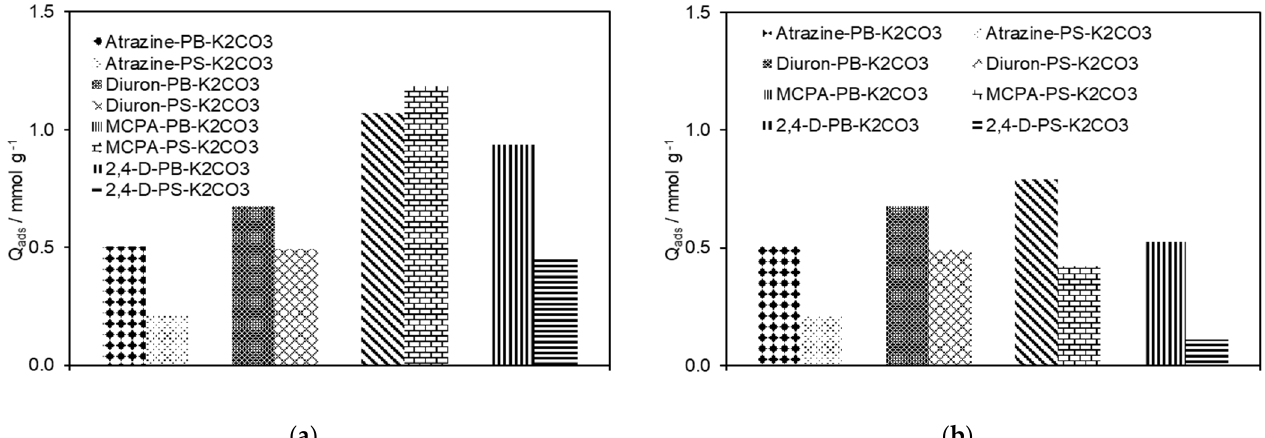
Figure 5. Adsorption kinetics of 2,4-D and MCPA, obtained on PB-K 2 CO 3 , at 298 K. Open data points represent the adsorption of 2,4-D and filled data points the adsorption of MCPA.